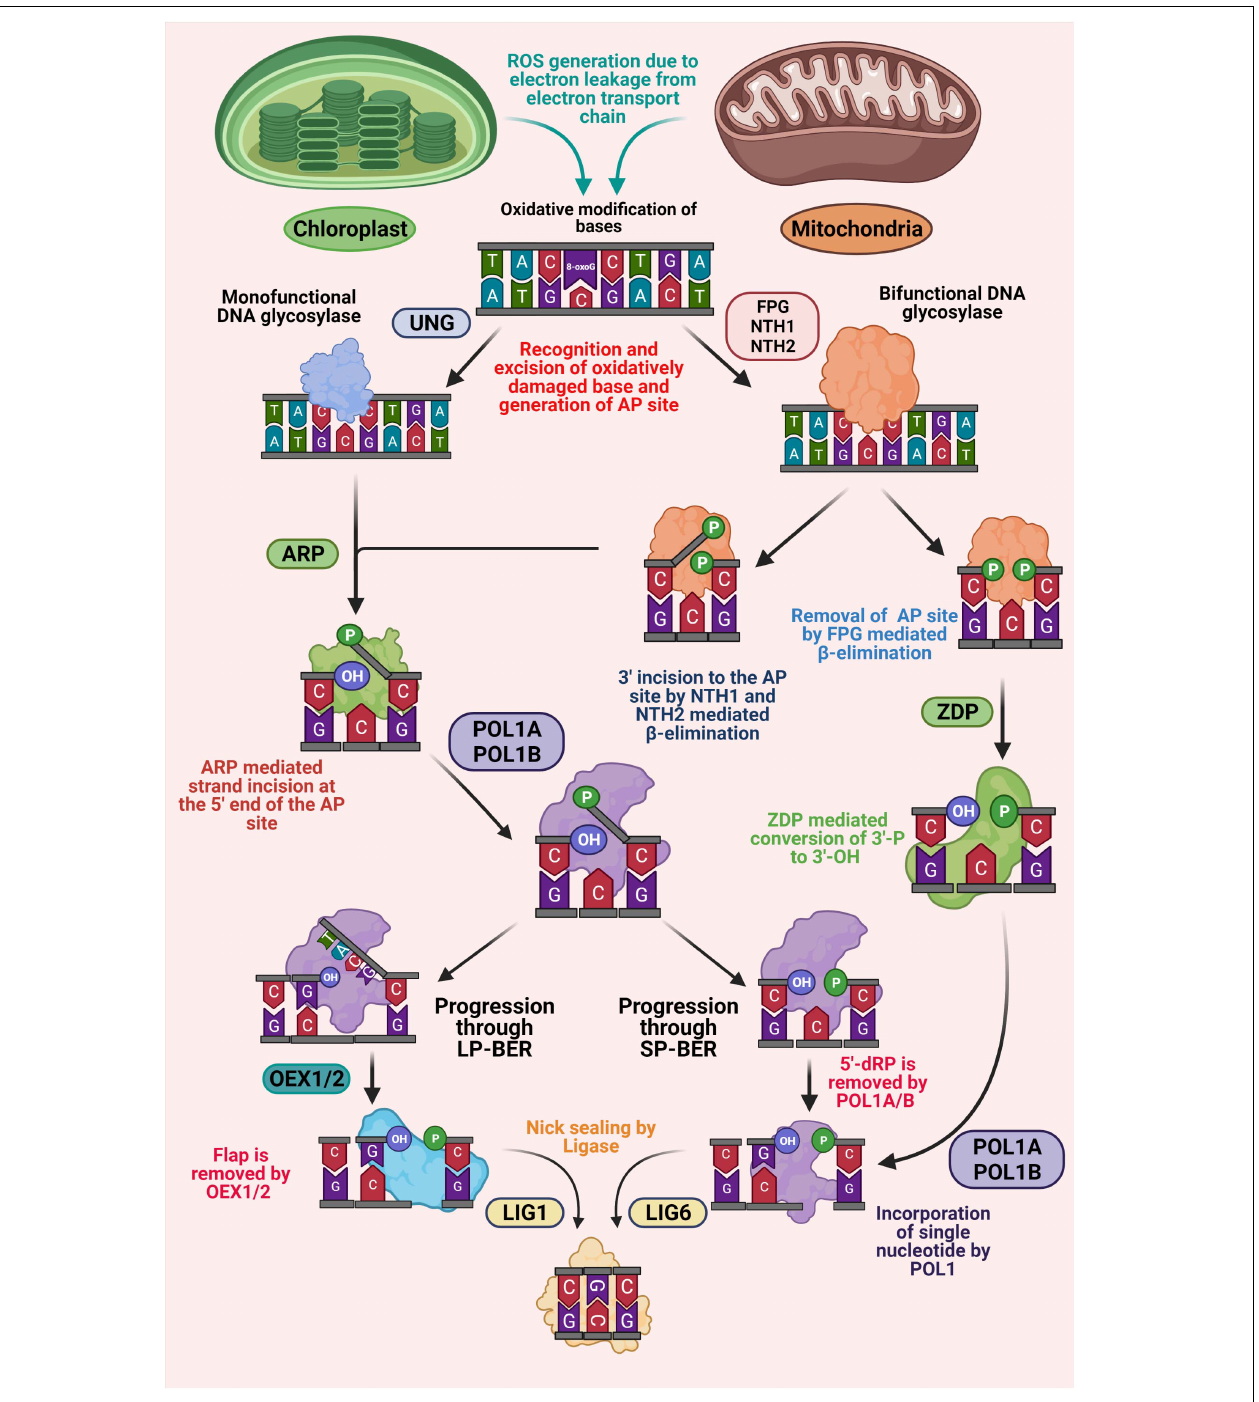
FIGURE 2 | Schematic representation of base excision repair (BER) in plant organelles. BER is initiated with recognition and removal of the oxidatively modified base by the action of DNA glycosylase, generating an AP site. Monofunctional glycosylase only possesses hydrolytic activity, while bifunctional glycosylases possess an additional lyase activity. An AP endonuclease (ARP) is associated with processing the AP sites produced by monofunctional glycosylases, thus generating 3 (cid:48) -OH and 5 (cid:48) -P ends. In addition, ARP also processes 3 (cid:48) -OH ends produced by bifunctional glycosylases generating 3 (cid:48) -OH and 5 (cid:48) -P ends. At this point, the BER pathway diverges into short-patch (SP) and long-patch (LP) sub pathways. The 50-flap generated by the action of POL1A and POL1B during LP-BER is cleaved by FEN1 endonuclease (OEX1 and OEX2). In SP-BER, the 5 (cid:48) -P moiety is processed by the lyase activity of POL1s and a single nucleotide is incorporated. DNA ligase is associated with the ligation process in both LP and SP-BER pathways. In addition, in an alternate pathway, a bifunctional glycosylase, FPG, remove oxidative DNA lesion, generating 3 (cid:48) -P and 5 (cid:48) -P ends. The 3 (cid:48) -P end is removed by ZDP phosphatase leaving a 3 (cid:48) -OH end, which is subsequently resolved through BER-SP.